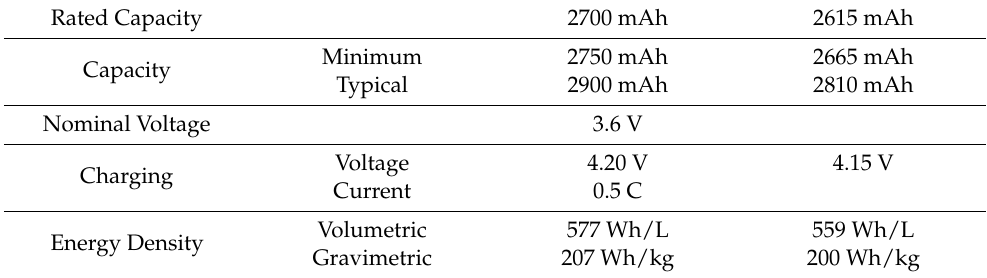
Table 1. 18650PF battery